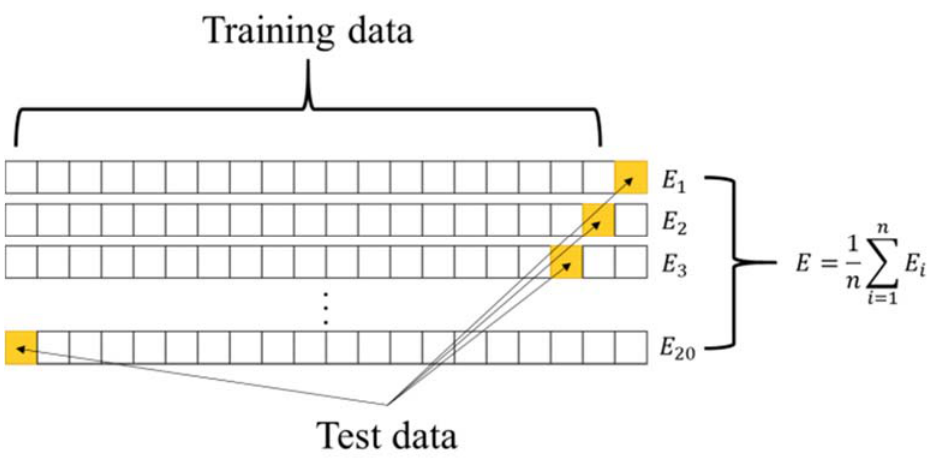
Figure 3. n-fold Figure 3. n ‐ fold Cross ‐ Validation.